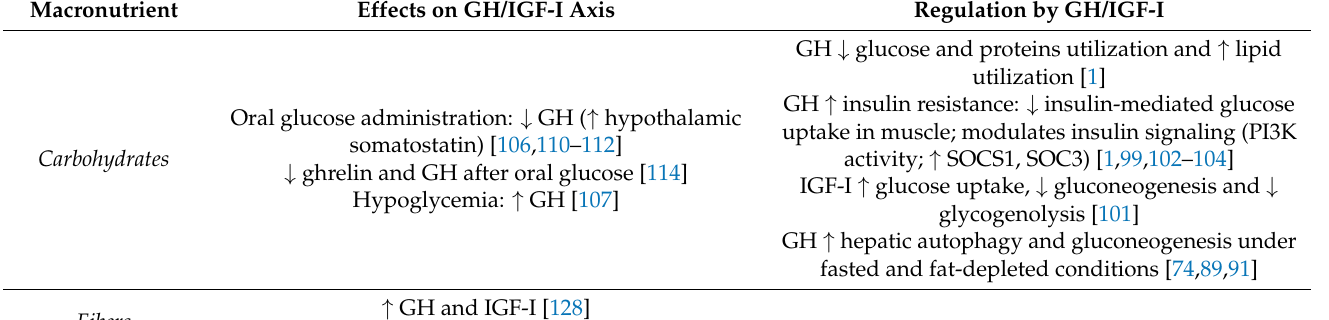
Table 1. Regulation among the GH/IGF-I axis and macronutrients ↑ = increase; ↓ = decrease. Macronutrient Effects on GH/IGF-I Axis Regulation by GH/IGF-I